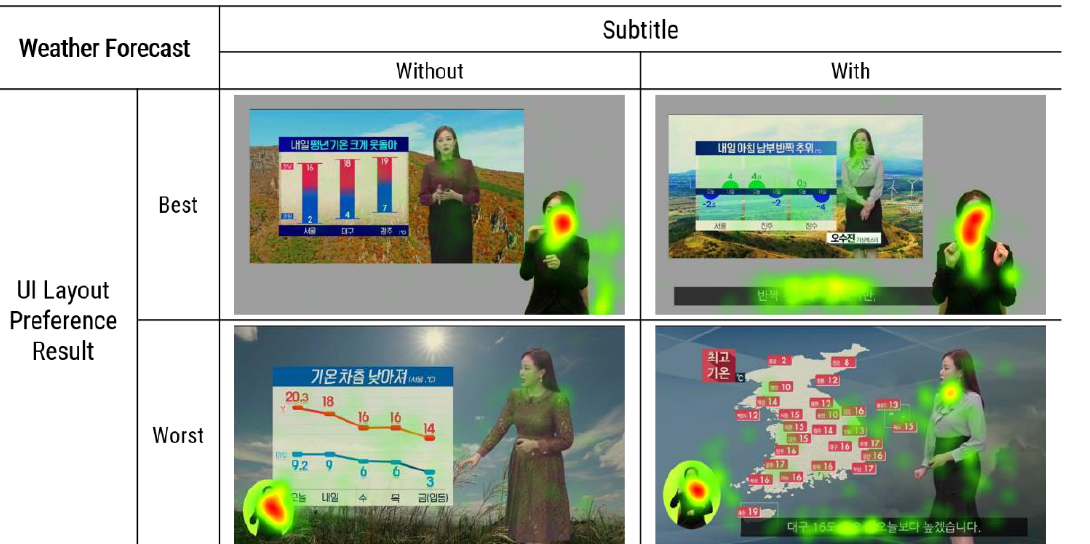
Figure 17. Results of preference evaluation with weather report clips.